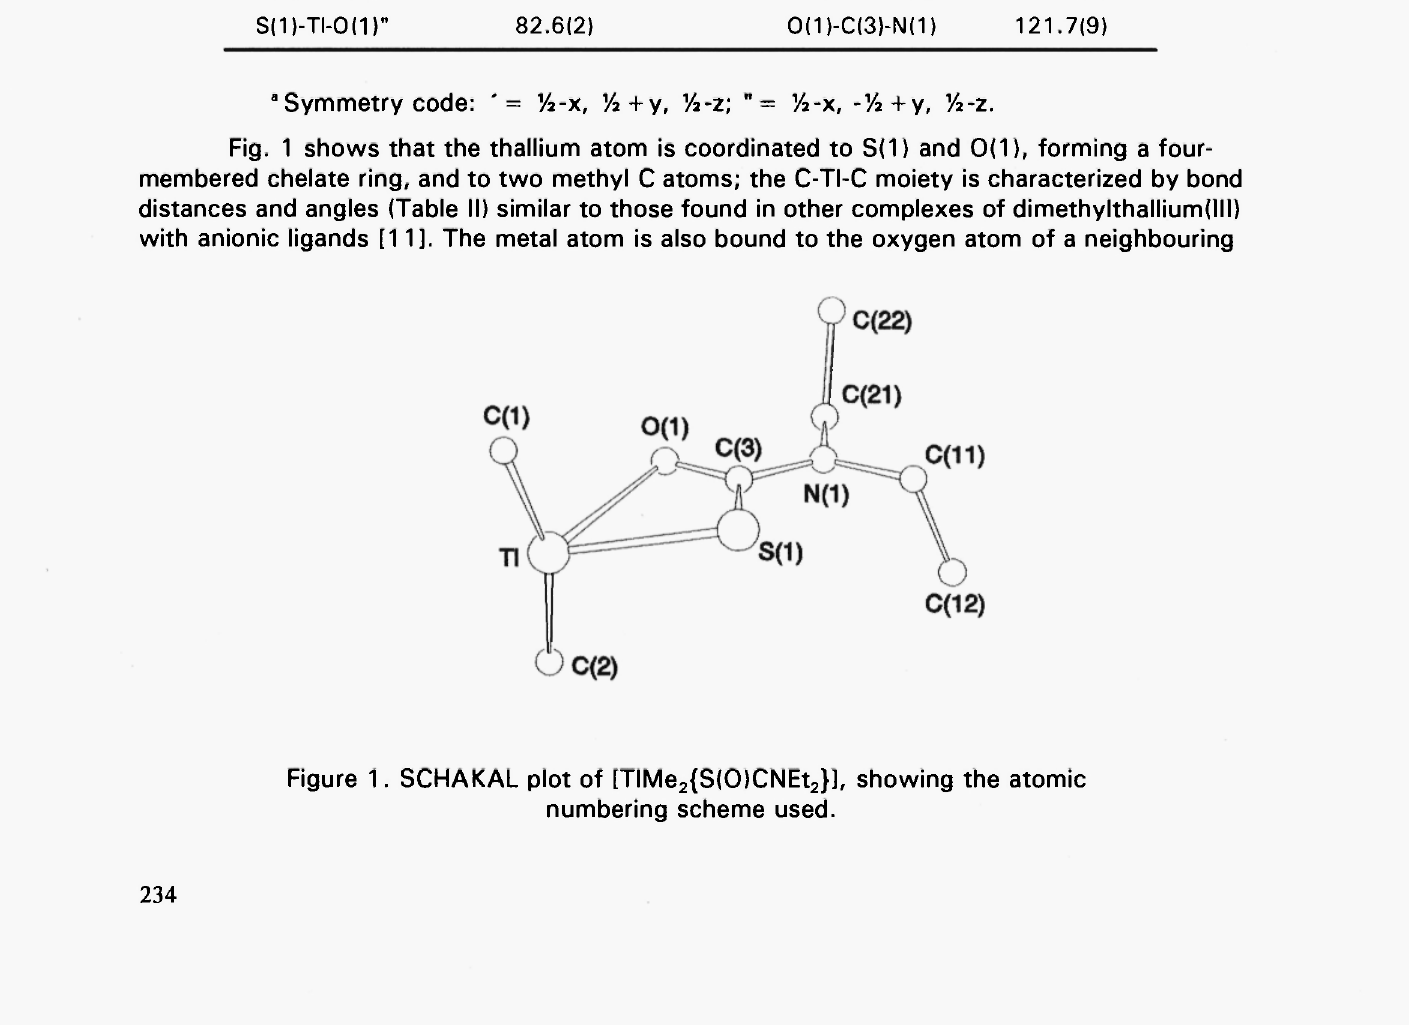
Figure 1. SCHAKAL plot of [TIMe 2 {S(0)CNEt 2 }], showing the atomic numbering scheme